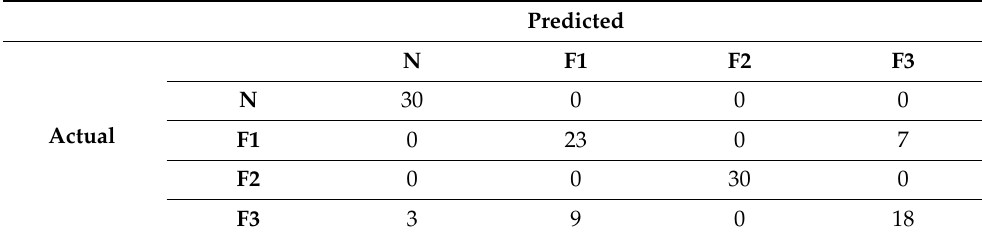
Table 2. Furnace: confusion matrix with ODE dataset, over unseen data.